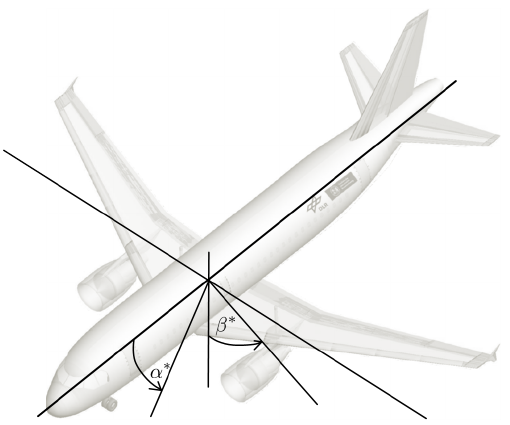
Figure 14. Definition of the emission angles α ∗ and β ∗